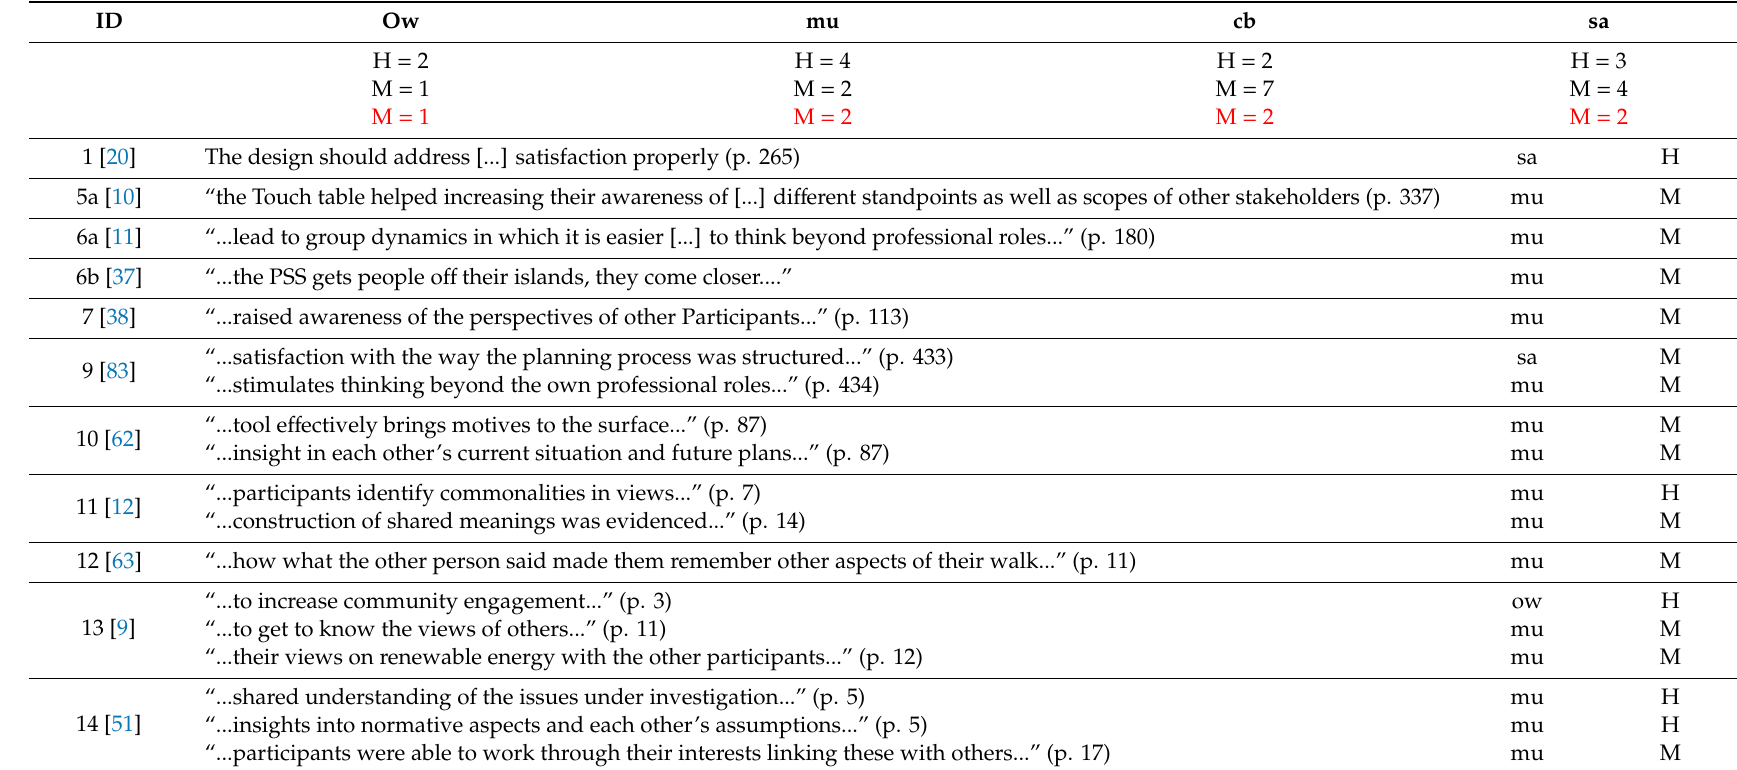
Table A7. Social